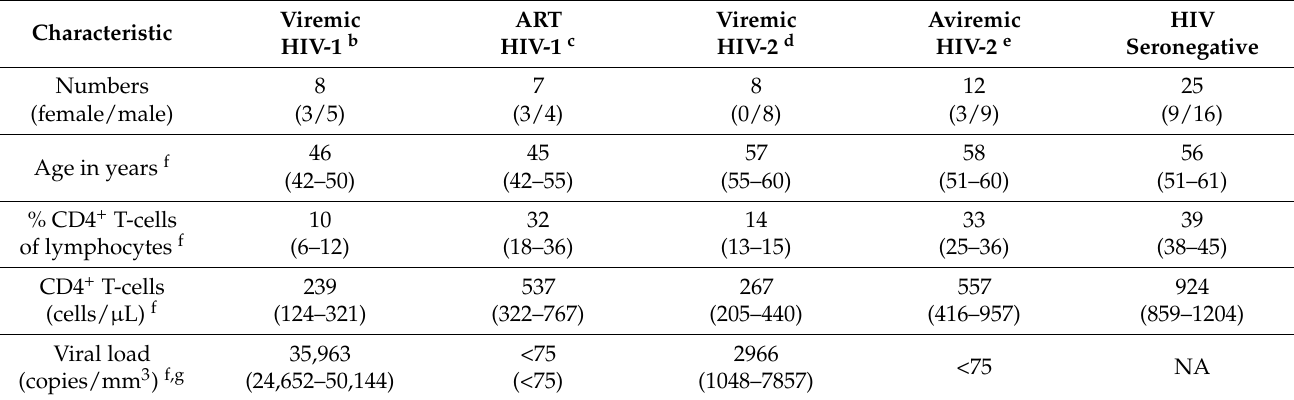
Table 1. Characteristics of study participants a